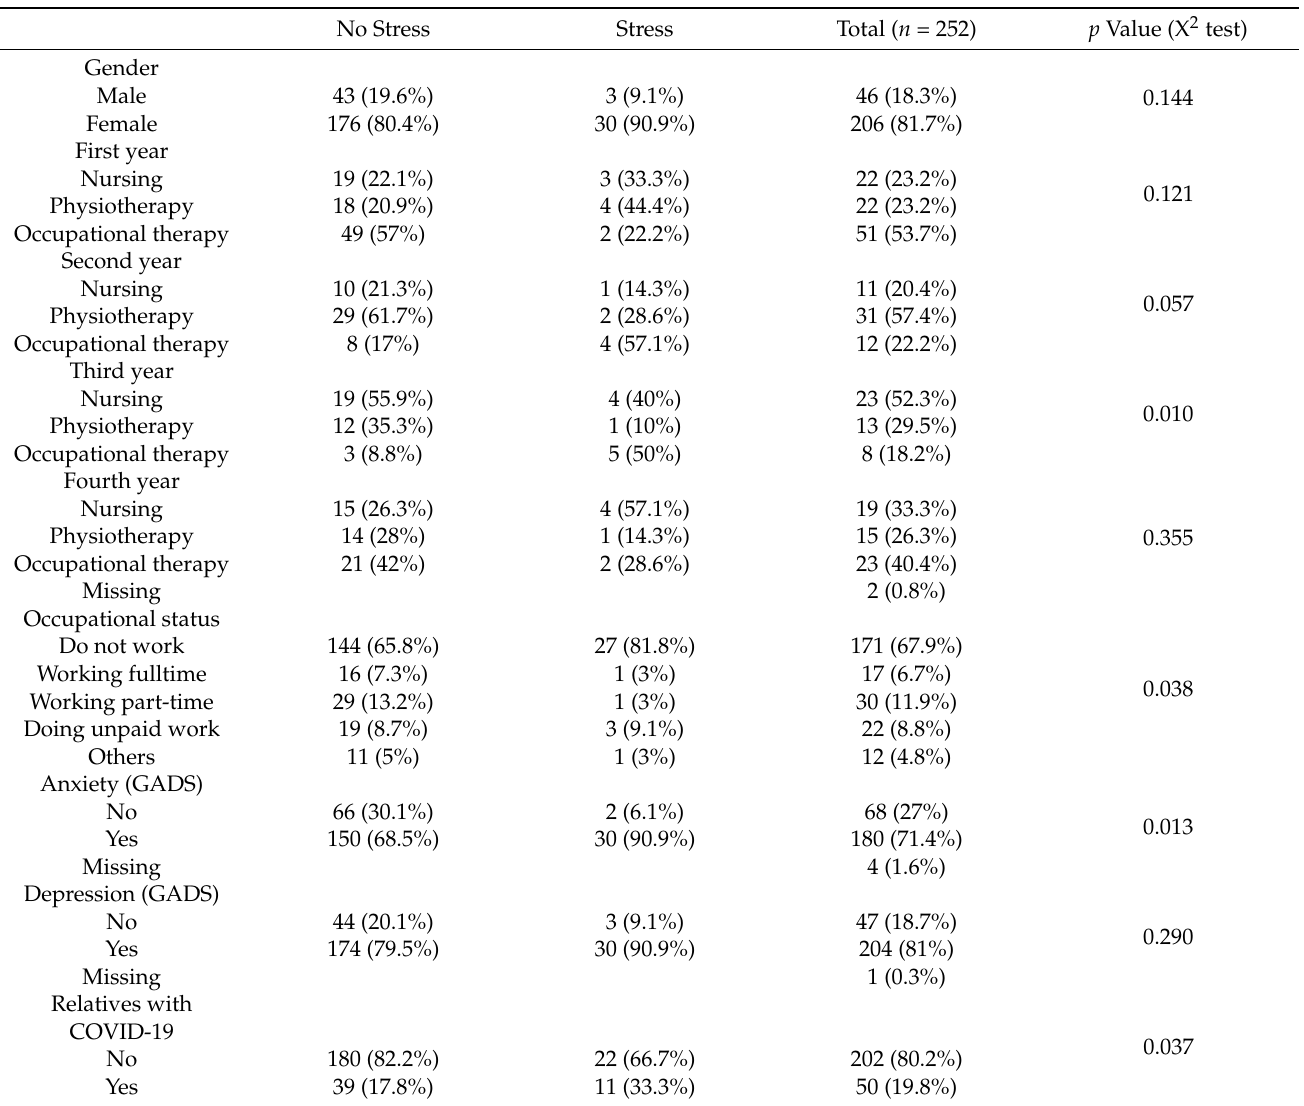
Table 3. Association between stress and socio-demographic